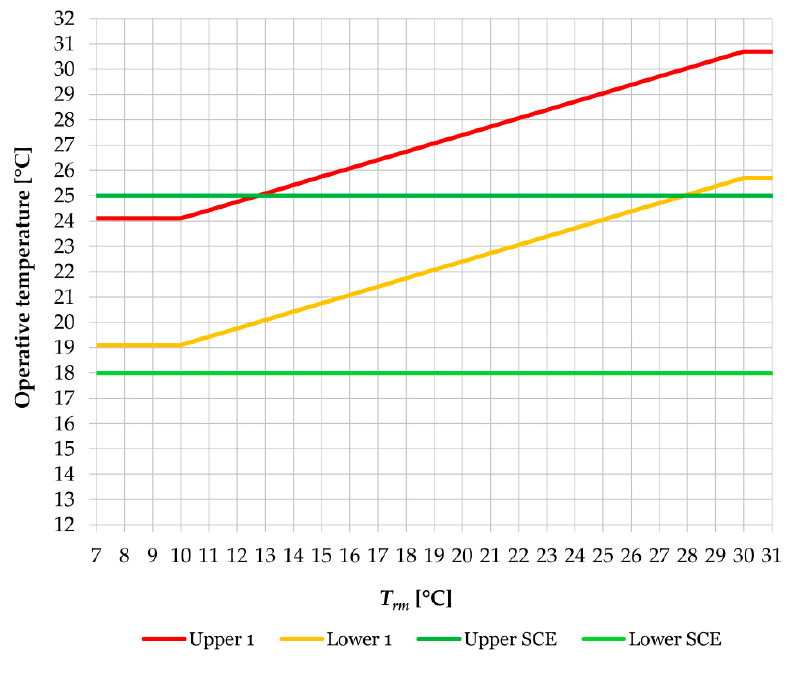
Figure 3. Thresholds for the considered comfort assessment approaches.